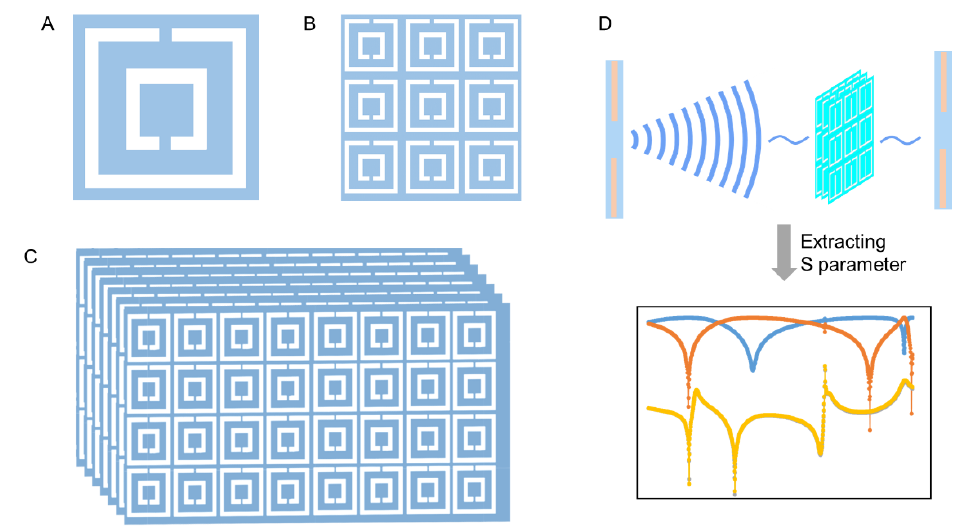
Figure 7. Illustration of metamaterials. ( A ) A single DSRR unit; ( B ) 2D DSRR array; ( C ) 3D DSRR crystal; ( D ) working principle of sensors based on metamaterials.